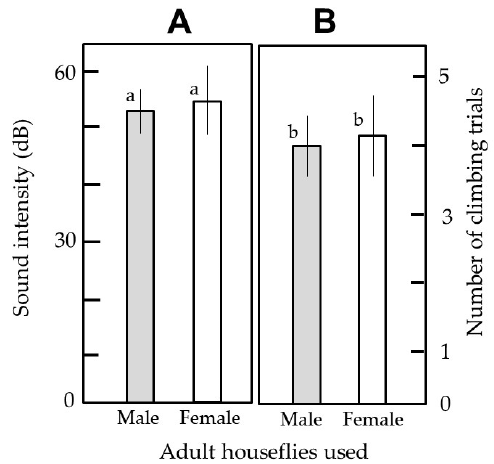
Figure 5. ( A ) The intensity of the sound produced by arc-discharge to a housefly climbing up the cylinder wall and reaching the arcing zone of the arc-discharge exposer (ADE) in the cylinder-climbing assay. ( B ) Number of climbing trials by houseflies exposed repeatedly to arc-discharge exposure until they died. We used 20 insects of each sex. Means ± standard deviation were calculated from five experimental replicates. The letters (a, b) on each column indicate no significant difference ( p < 0.05) according to Tukey’s test.